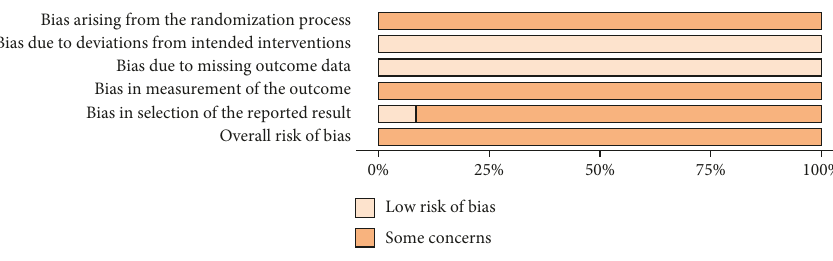
Figure 6: Risk of bias of included